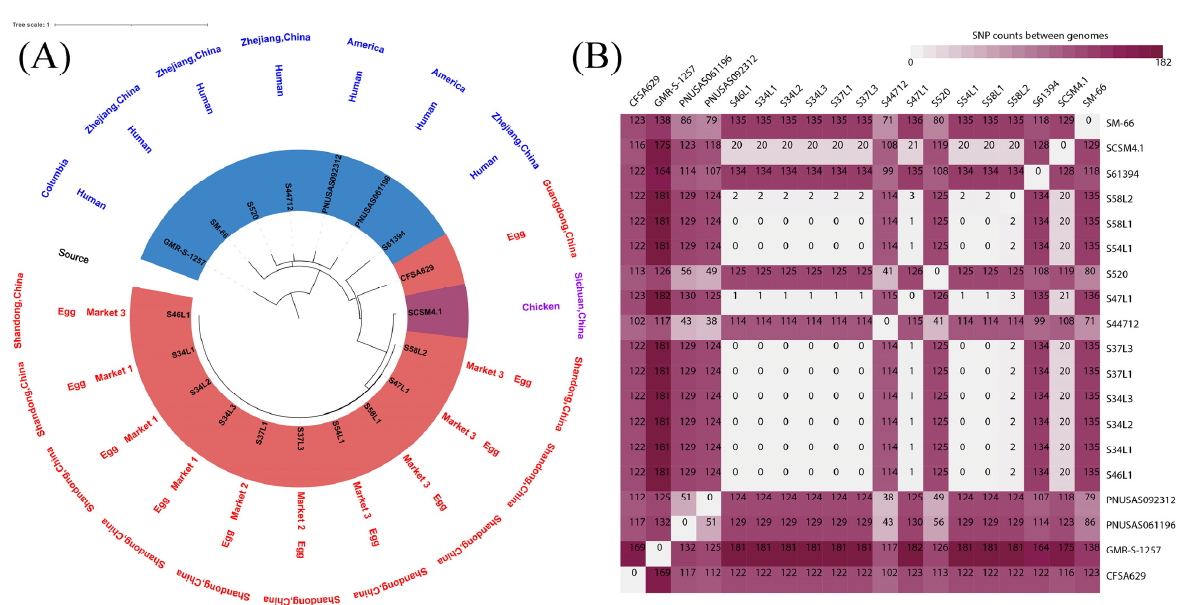
Figure 3. Phylogenetic analysis ( A ) and SNPs variation ( B ) of the 19 mcr-1 -harboring ST34 S . Typhimurium isolates from different countries and different sources, including nine genomes from the NCBI database and 10 isolates in this study.